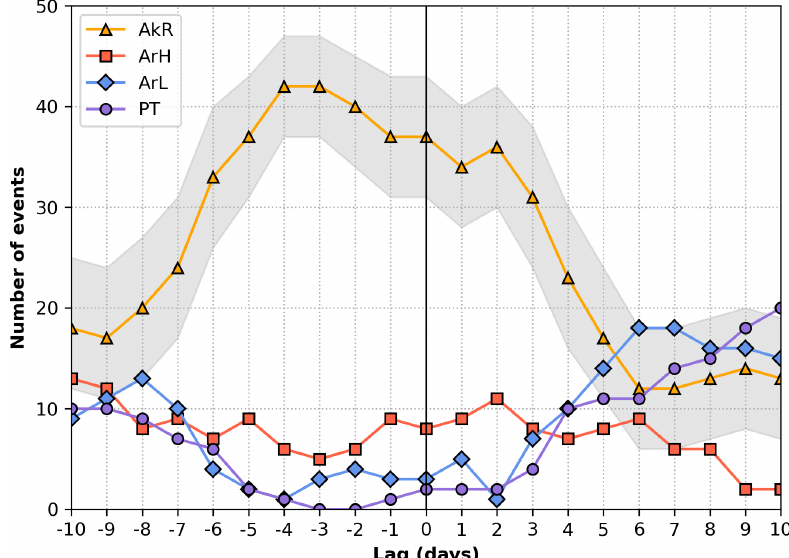
Figure A9. Number of weather regime occurrences at different lags centred around the 50 coldest cold spells over 40–55 ◦ N and 260–290 ◦ E. Note that cold spells within the first 10d of December and last 10d of March have been removed. Shading indicates the 95% confidence interval for the AkR regime, assessed as described in Sect.